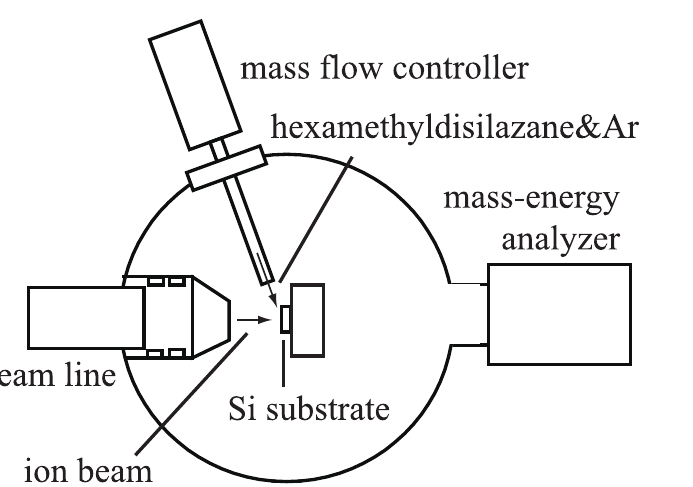
Fig 1. A schematic drawing of the processing chamber of the ion beam system.